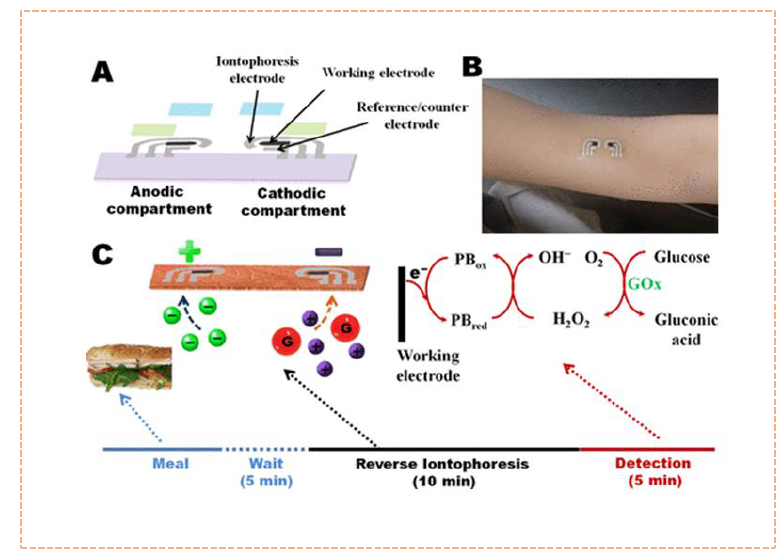
Figure 2. A tattoo based electrochemical sensor for glucose sensing. ( A ). The iontophoretic-sensor displaying the tattoo-based paper with Ag/AgCl and Prussian blue electrodes, insulating layer and hydrogel layer; ( B ). Image of the tattoo for glucose sensing; ( C ). Diagram representing the different processes involved in each stage of sensing. (Reprinted from [43] which is an open access article distributed under the Creative Commons Attribution License).